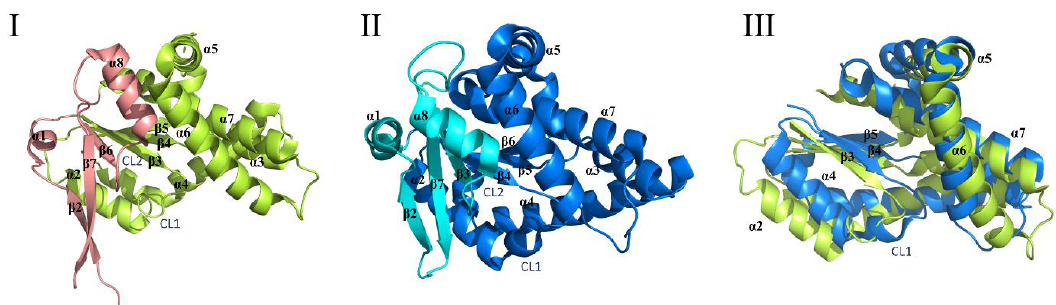
Figure 3. ( I ) Structure of XYP Rgry-cyclodipeptide synthases (CDPS). The first half of the Rossmann fold is shown in cyan, and the second half of the Rossmann fold is shown in limon. The protein C-terminal positions of residues 236 to 259 are not shown [51]. ( II ) Structure of NYH CDPS from Streptomyces . The first half of the Rossmann fold is shown in aquamarine, and the second half of the Rossmann fold is shown in marine [51]. ( III ) To better show the differences between the two subfamilies, the second part of the Rossmann fold of AlbC is superimposed to Rgry-CDPS [51], Rgry is represented by limon, and AlbC is represented by marine.